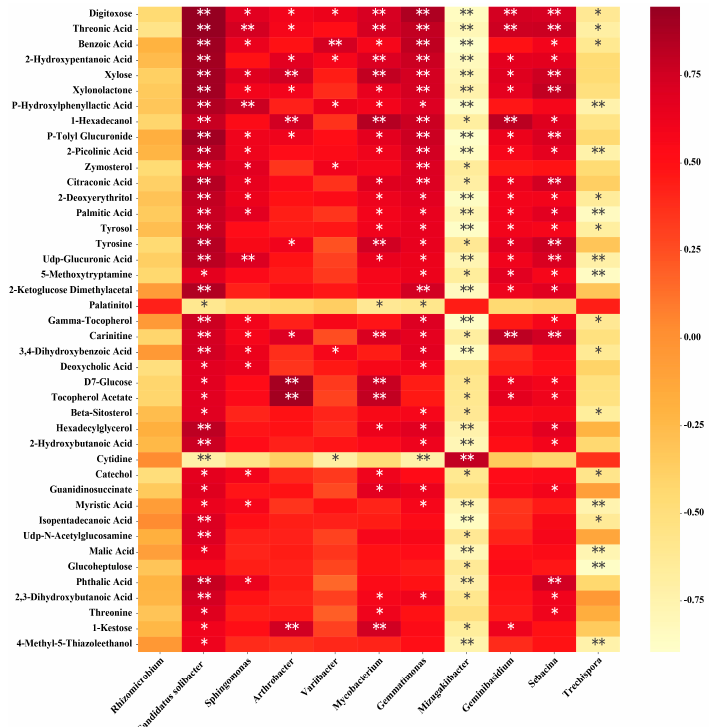
Figure 8. Heatmap of correlation analysis between microorganism relative abundances at genus level and metabolite relative contents. * and ** indicate a significant correlation at p < 0.05 and p < 0.01, respectively. The depth of the orange scale represents the magnitude of the correlation coefficient, where the darker the color, the greater the positive